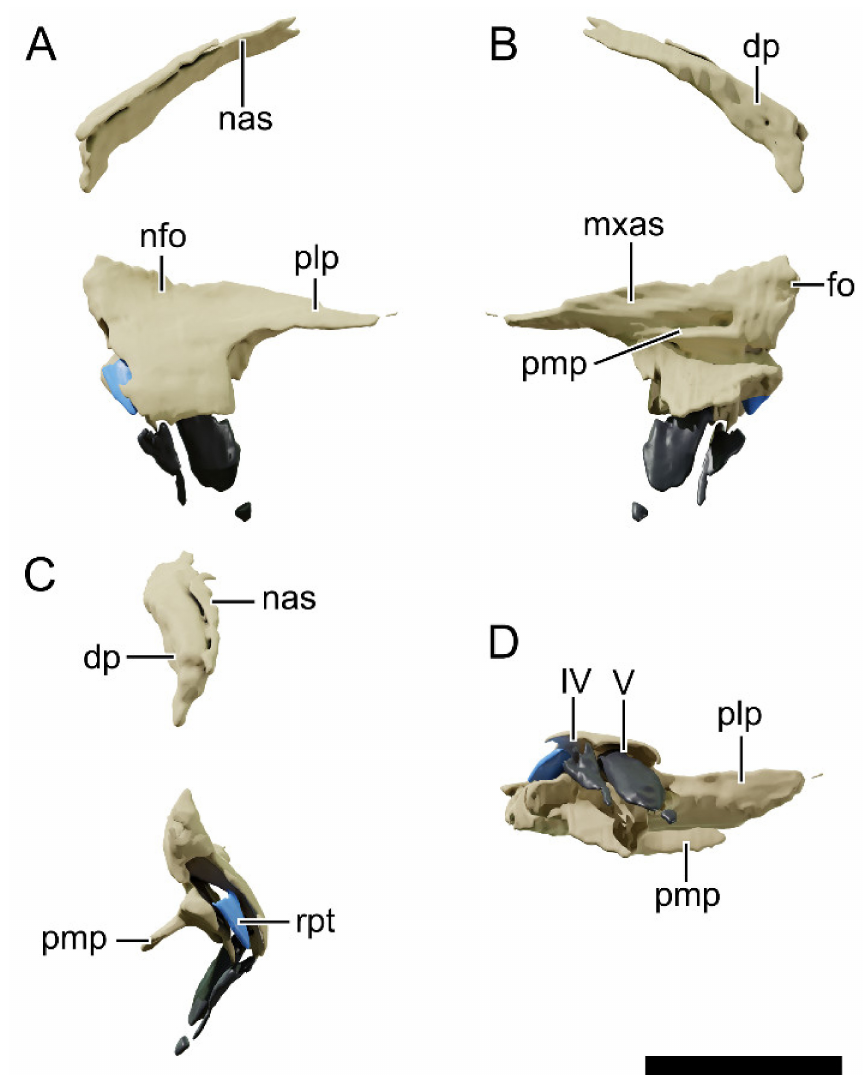
Figure 8. Digital reconstruction of the left premaxilla of NHMD 164741. ( A ) Lateral view. ( B ) Medial view. ( C ) Anterior view. ( D ) Ventral view. Abbreviations: dp, dorsal process; fo, foramen; mxas, articular surface for the maxilla; nas, articular surface for the nasal; nfo, narial fossa; plp, posterolateral process; pmp, posteromedial process; rpt, replacement tooth. IV and V represent the tooth position. Scale bar = 20